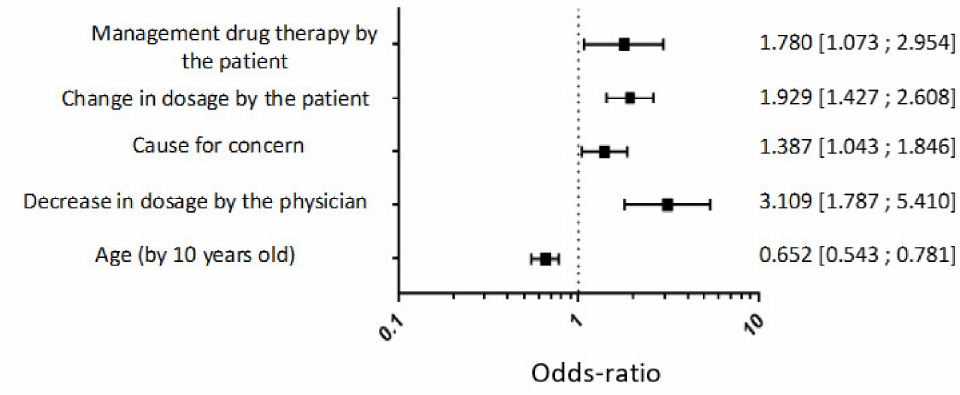
Figure 3. Multivariate logistic regression analysis to identify factors of a wish to withdrawal hypnotic